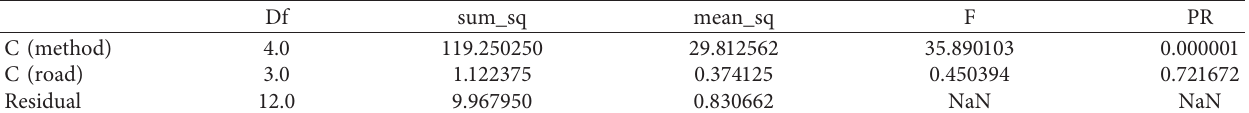
Table 5: Significant test